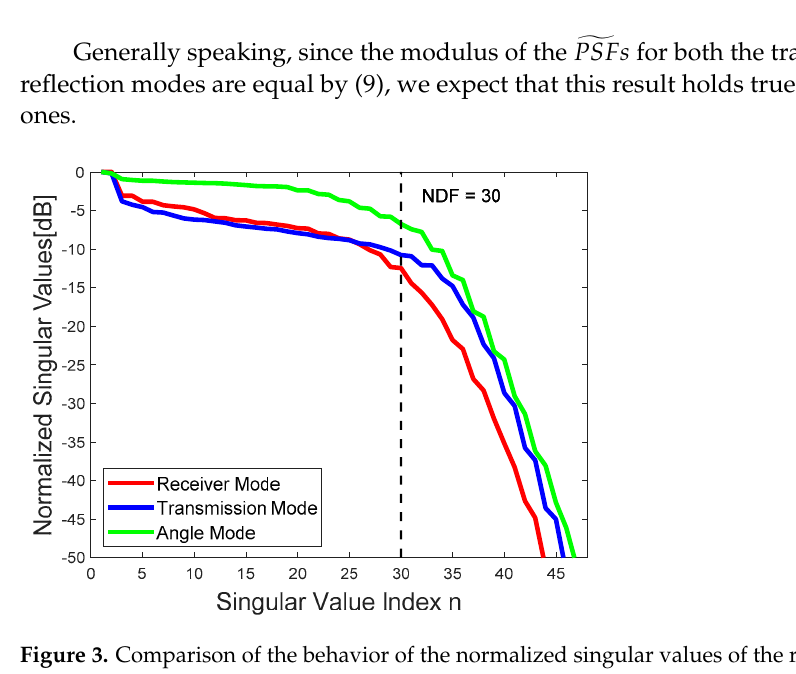
Figure 5. Comparison of the actual PSFs of three sensing modes for 𝜙 (cid:2868) = 𝜋 2⁄ (red lines), 𝜙 (cid:2868) = 5 𝜋 6⁄ (blue lines), 𝜙 (cid:2868) = 𝜋 (green lines). The solid, dotted, and dashed lines indicate the reflection, transmission, and angle modes. In order to confirm the performance of the approximated 𝑃𝑆𝐹(cid:3562) , a comparison be- tween it and the actual PSF for three sensing modes is provided, as shown in Figure 6. Since we are only interested in the main lobe of the 𝑃𝑆𝐹(cid:3562) we show only it. The amplitude of both PSFs normalized to 1. The numerical example verifies that the approximation is acceptable, at least in the main lobe. As can be observed, the approximation does not over- lap exactly with the actual in the 𝜙 (cid:2868) = 𝜋 2⁄ in the reflection and transmission modes be- cause the point is located outside of the observation ranges. Its performance can improve when the scatterer point is located inside the ranges. Consequently, the plane wave direc- tions and observation directions are important for reconstructing the point-like scatterer. Therefore, we can conclude that the resolution depends on the position of the scatterer point and on the adopted sensing mode.